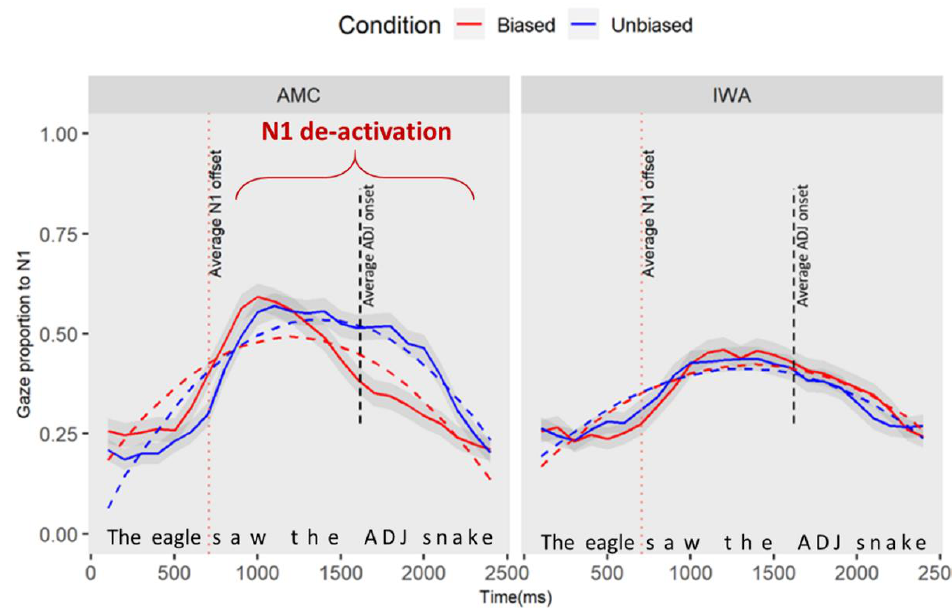
Figure 5. The plot captures the part of the sentence as “the eagle saw the/adjective/snake”. This plot demonstrates the gaze proportion differences to N1 between conditions and groups. Solid lines represent observed data and dashed lines represent the GCA model fit. The graphic representation of the model is showing the quadratic fit, yet the significant results for the condition effect were observed at the linear term.